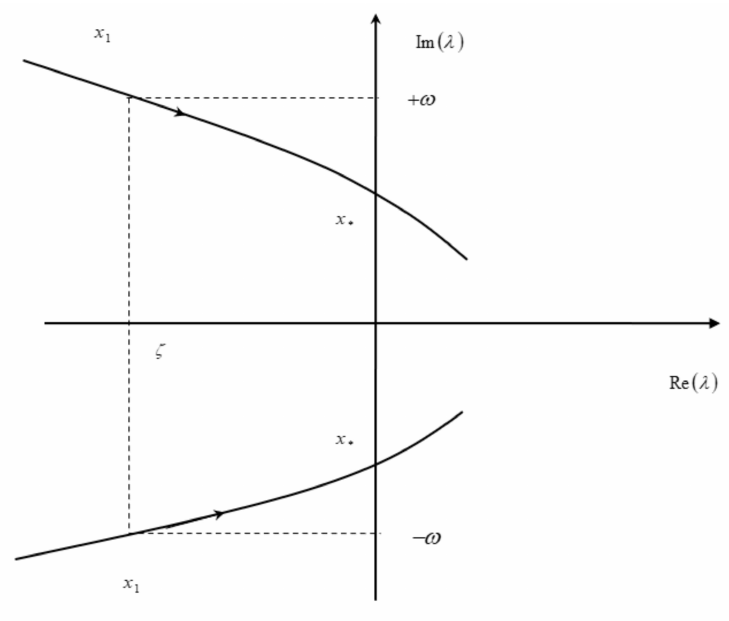
Figure 10. Manouever points of first kind for oscillatory modes at zero damping.